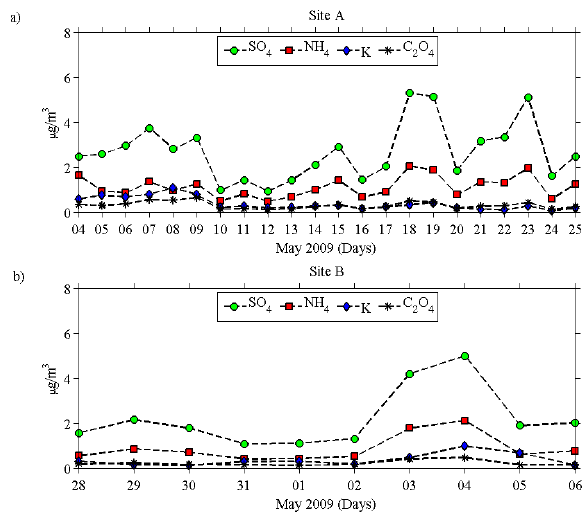
Figure 10 : Daily composition of major PM2.5 ionic compounds for Site A (a) and Site B (b). The ionic species were dominated by + 4 NH and − 2 4 SO at both sites with lower mean concentrations at Site B. The peak in the ionic concentrations is associated with the presence of synoptic scale pollution episodes.